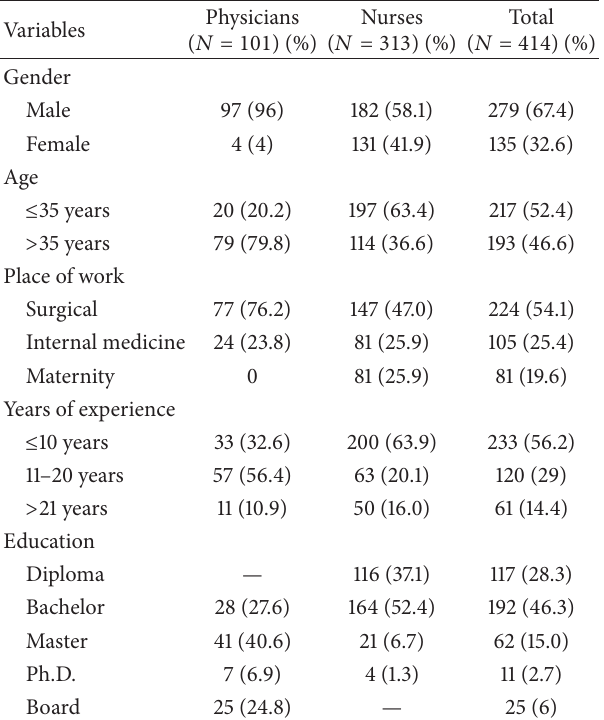
Table 1: Sociodemographic characteristics of participants ( 𝑁 = 414